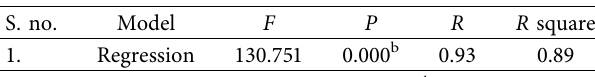
Table 7: Significance of the econometric model (ANOVA a